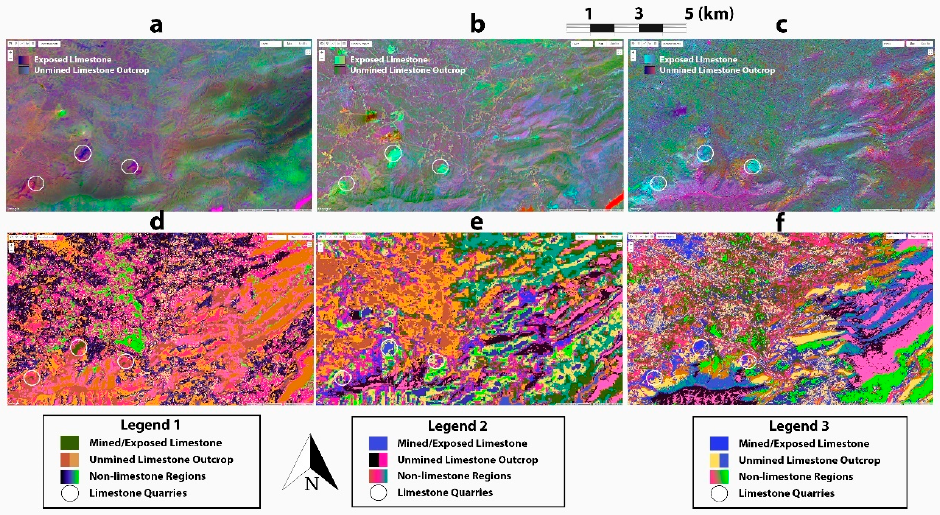
Figure 5. Decorrelation stretching of ( a ) Landsat-8, ( b ) ASTER, ( c ) Sentinel-2, and X-means clustering of ( d ) Landsat-8, ( e ) ASTER, and ( f ) Sentinel-2 datasets of Hattar, Khyber Pakhtunkhwa,